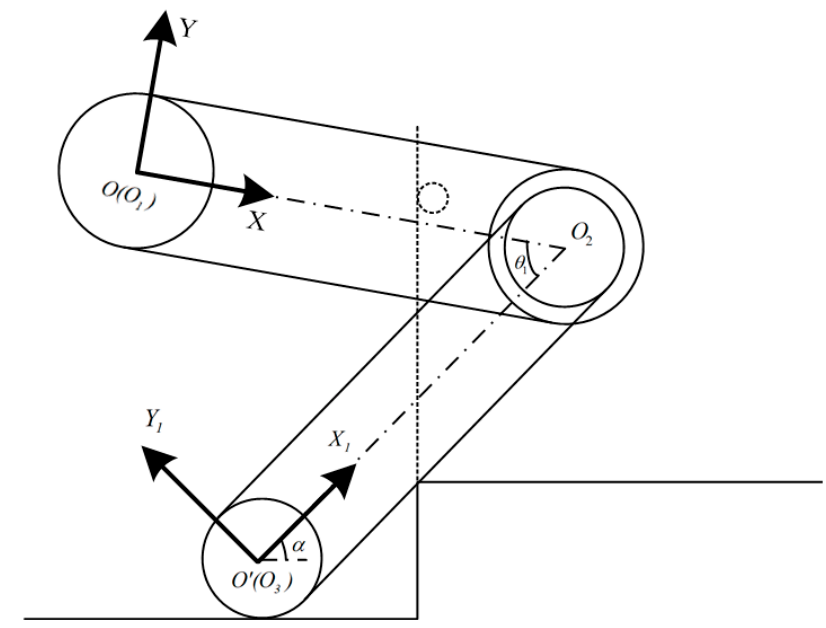
where r is the cross-country wheel radius.